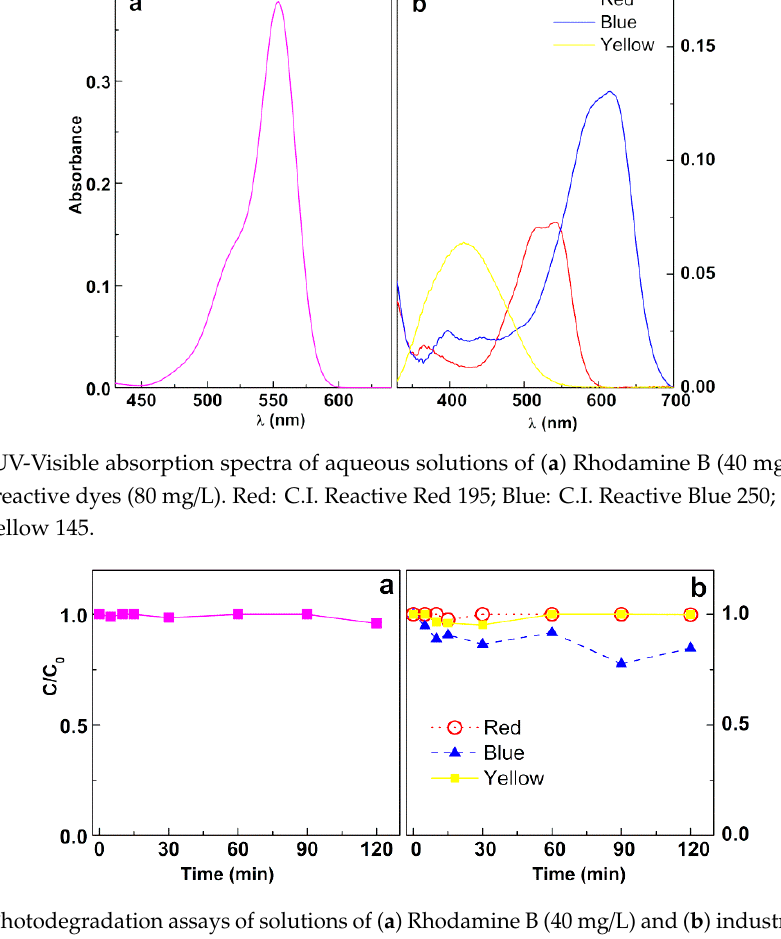
Figure 7. Photodegradation assays of solutions of ( a ) Rhodamine B (40 mg / L) and ( b ) industrial reactive dyes (80 mg / L) in the absence of magnetic nanoparticles. Red: C.I. Reactive Red 195; Blue: C.I. Reactive Blue 250; Yellow: C.I. Reactive Yellow 145.